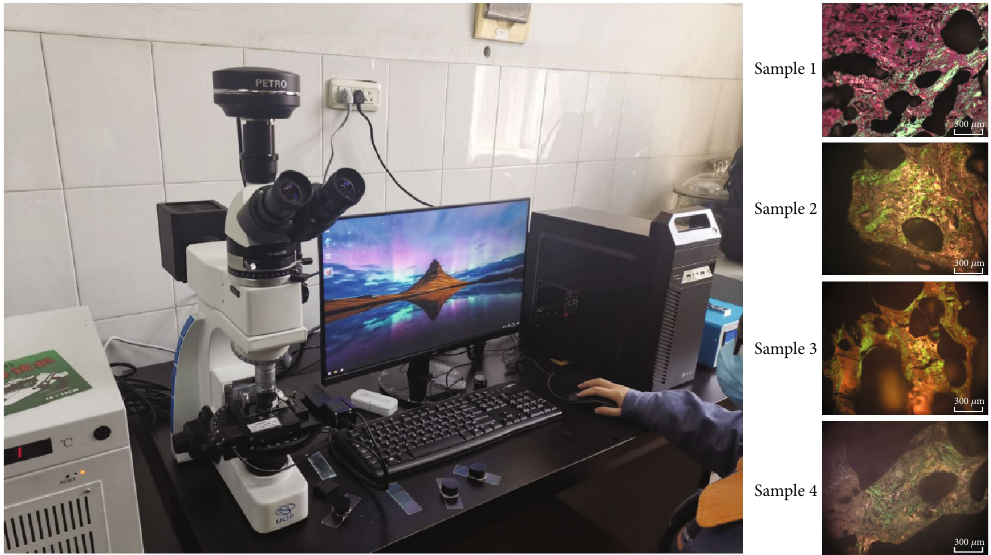
Figure 13: Experimental platform and sample images.